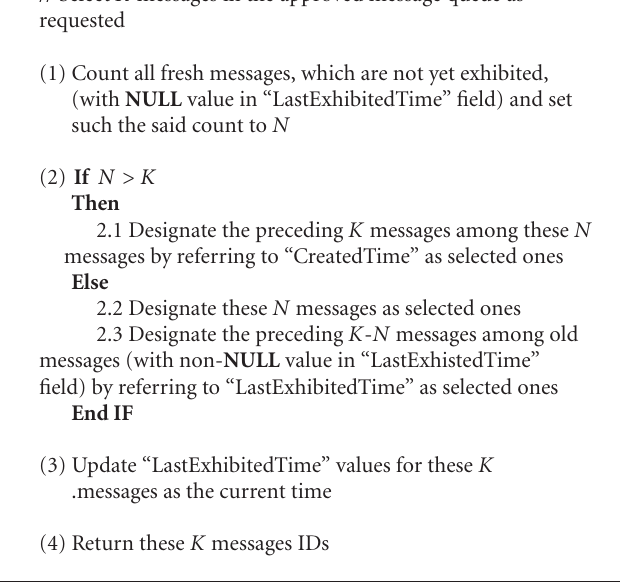
Algorithm 1: Algorithm of FCFS-based selection with LRU